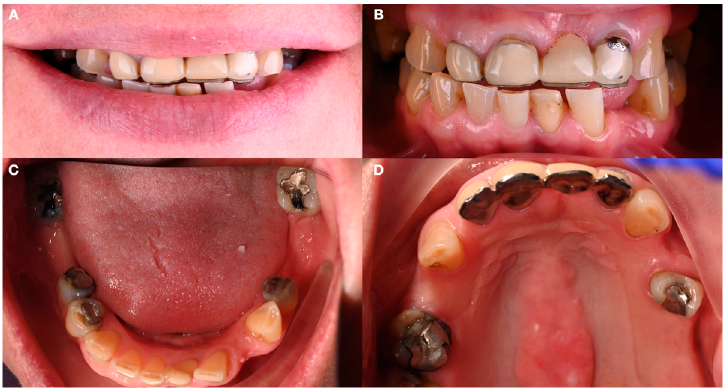
Figure 3. Initial intraoral photos. ( A ) Smile. ( B ) Frontal view in occlusion. ( C ) Occlusal view of the mandible. ( D ) Occlusal view of the maxilla.